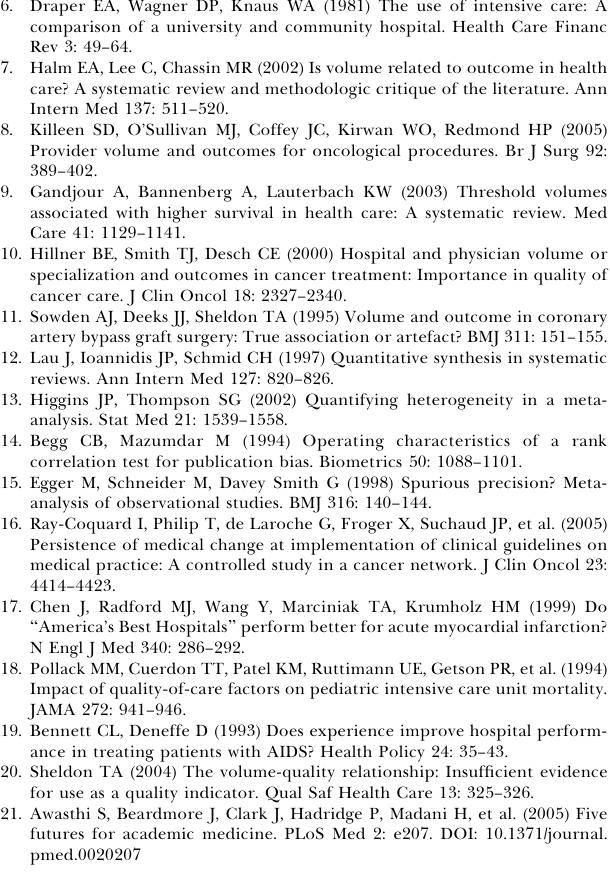
Table S1. Excluded Studies and Reasons for Exclusion Found at DOI: 10.1371/journal.pmed.0030341.st001 (61 KB DOC). Table S2. Eligible Studies Containing Only Unadjusted or Nonusable Data on Mortality Found at DOI: 10.1371/journal.pmed.0030341.st002 (41 KB